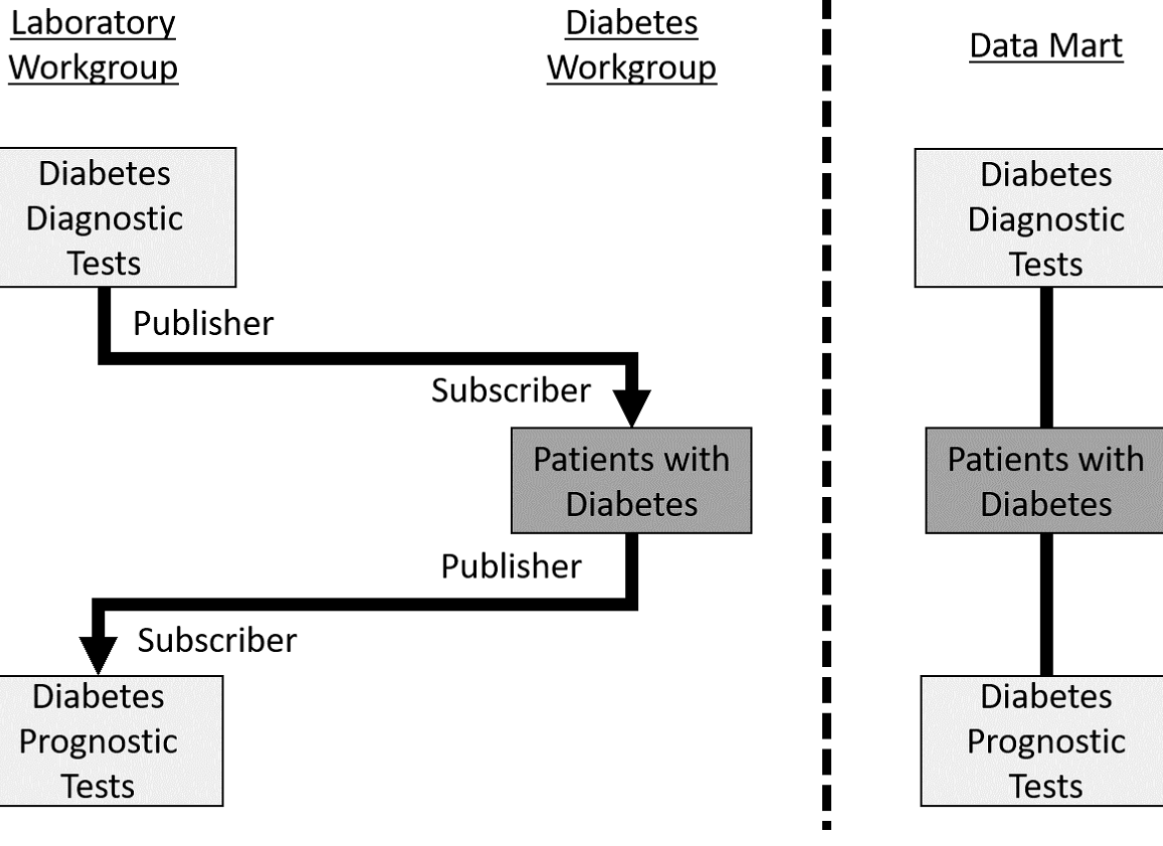
Figure 3. Creating a diabetes data mart with the Data Object Exchange (DOEx) and the dynamic data pipeline design pattern. (Left) The publisher/subscriber relationship between the laboratory and diabetes workgroups. Each rectangle represents a dynamic data design pattern. The arrows denote the data processing sequence. (Right) A subset of the final data mart: a database table of patients with diabetes and their prognostic